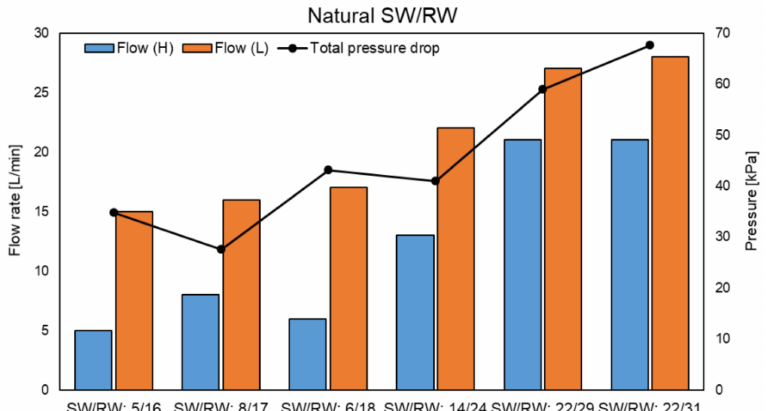
Figure A11. RED stack pressure drops as a function of the feed flow rate using natural